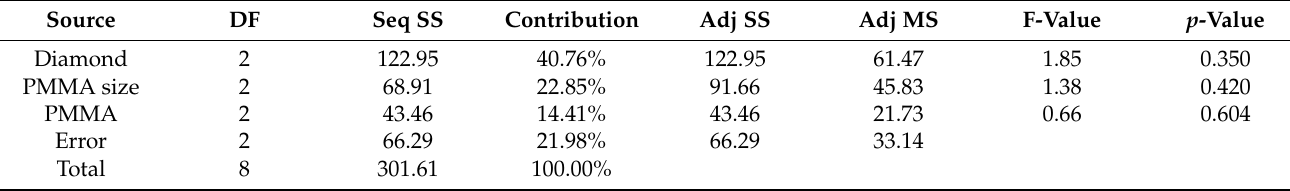
Table 5. ANOVA variance table for plateau stress.